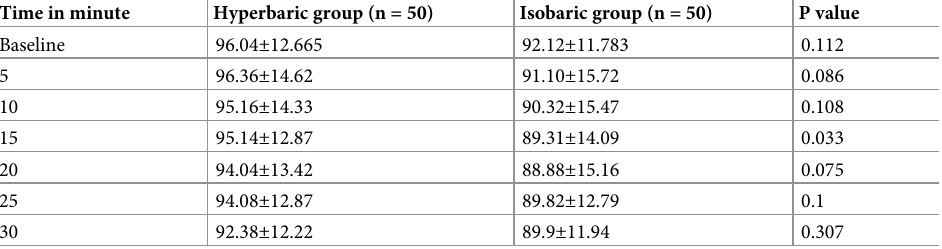
Table 2. Change in HR in first 30 minute among groups at Gandhi Memorial Hospital, Addis Ababa, Ethiopia, 2018. Time in